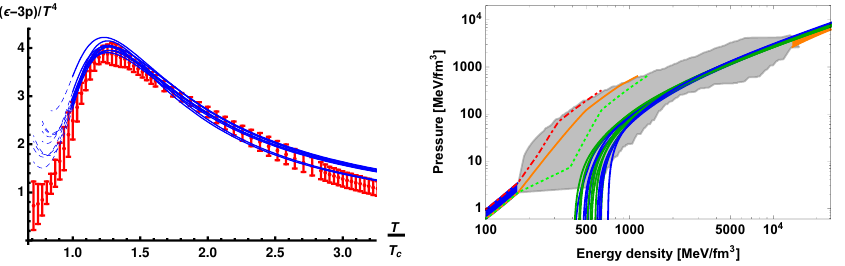
Figure 1. Thermodynamics in the V-QCD model. Left: Fit of the model (blue curves) to lattice data [38] (red dots and error bars). Right: Extrapolation of the EOS to zero temperature (blue and green curves), compared to the band of interpolated EOSs [39] and to nuclear matter EOSs [40]. Figures from